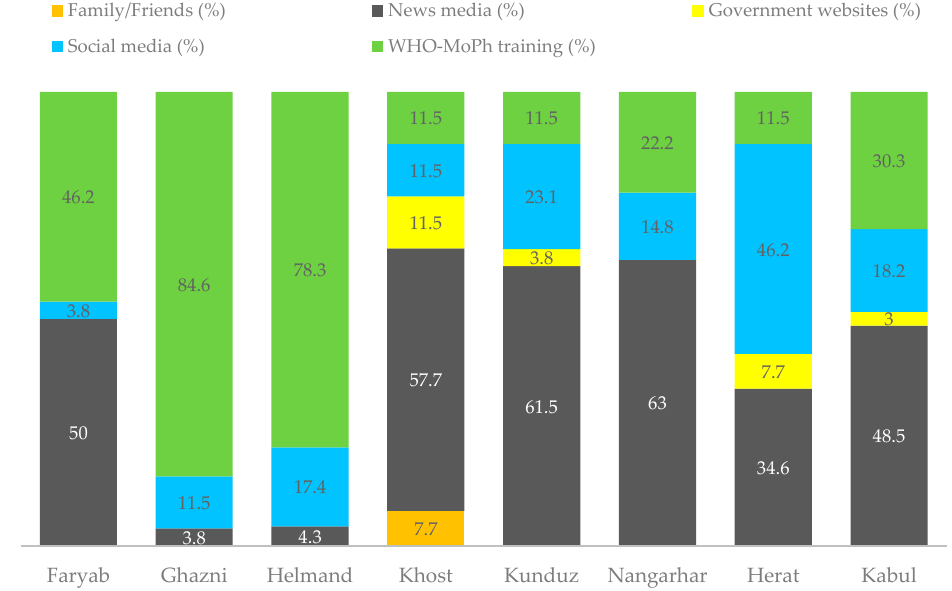
Figure 2: Figure 2: Source of receiving COVID-19-related information . Figure 2. Source of receiving COVID-19-related